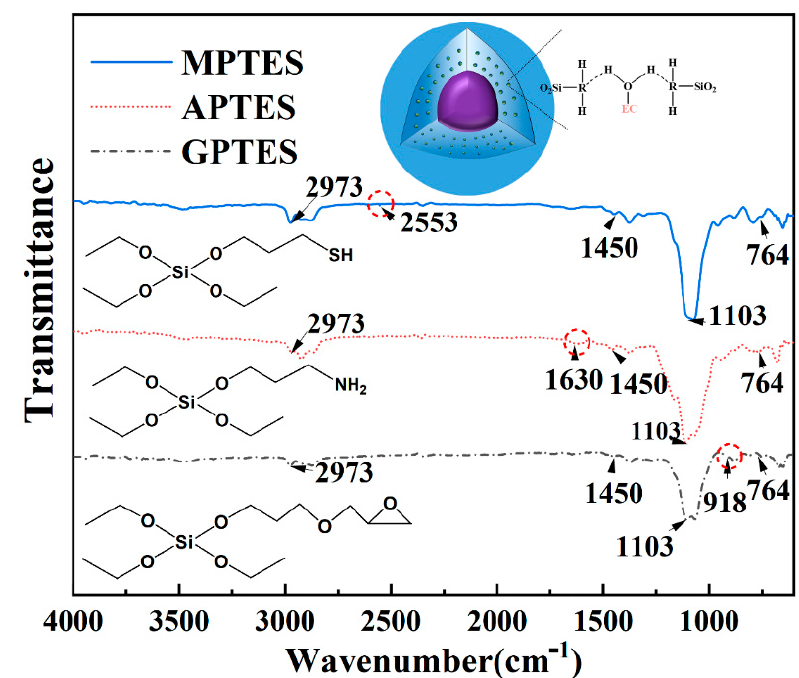
Figure 3. FTIR diagram of the three modified EC/SiO 2 shell materials.